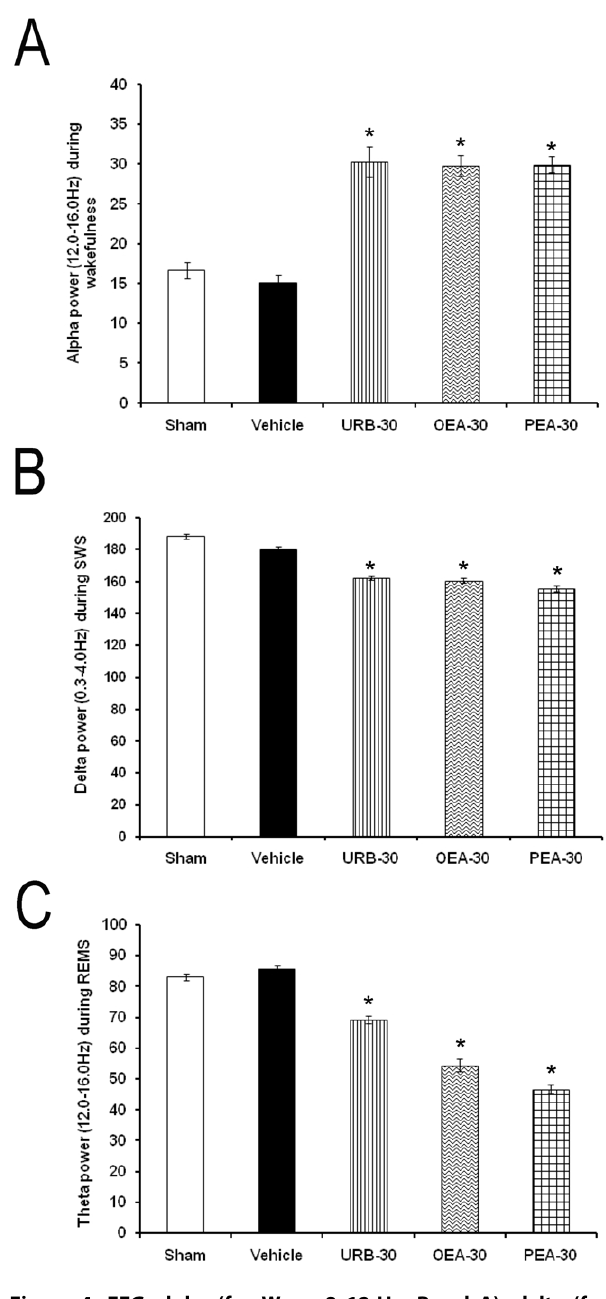
Figure 4. EEG alpha (for W; a =8–12 Hz. Panel A), delta (for SWS; d =0.5–4.0 Hz. Panel B) and theta (for REMS; h =6.0– 12.0 Hz. Panel C) power spectra (units, m V 2 ) in rats after the following treatments into lateral hypothalamus: Sham, vehicle, URB597, OEA or PEA (30 m g/1 m L; each compound). Data were calculated over 3 consecutive hours at every time point (Mean 6 SEM; * vs. Sham/Vehicle, p , 0.05).